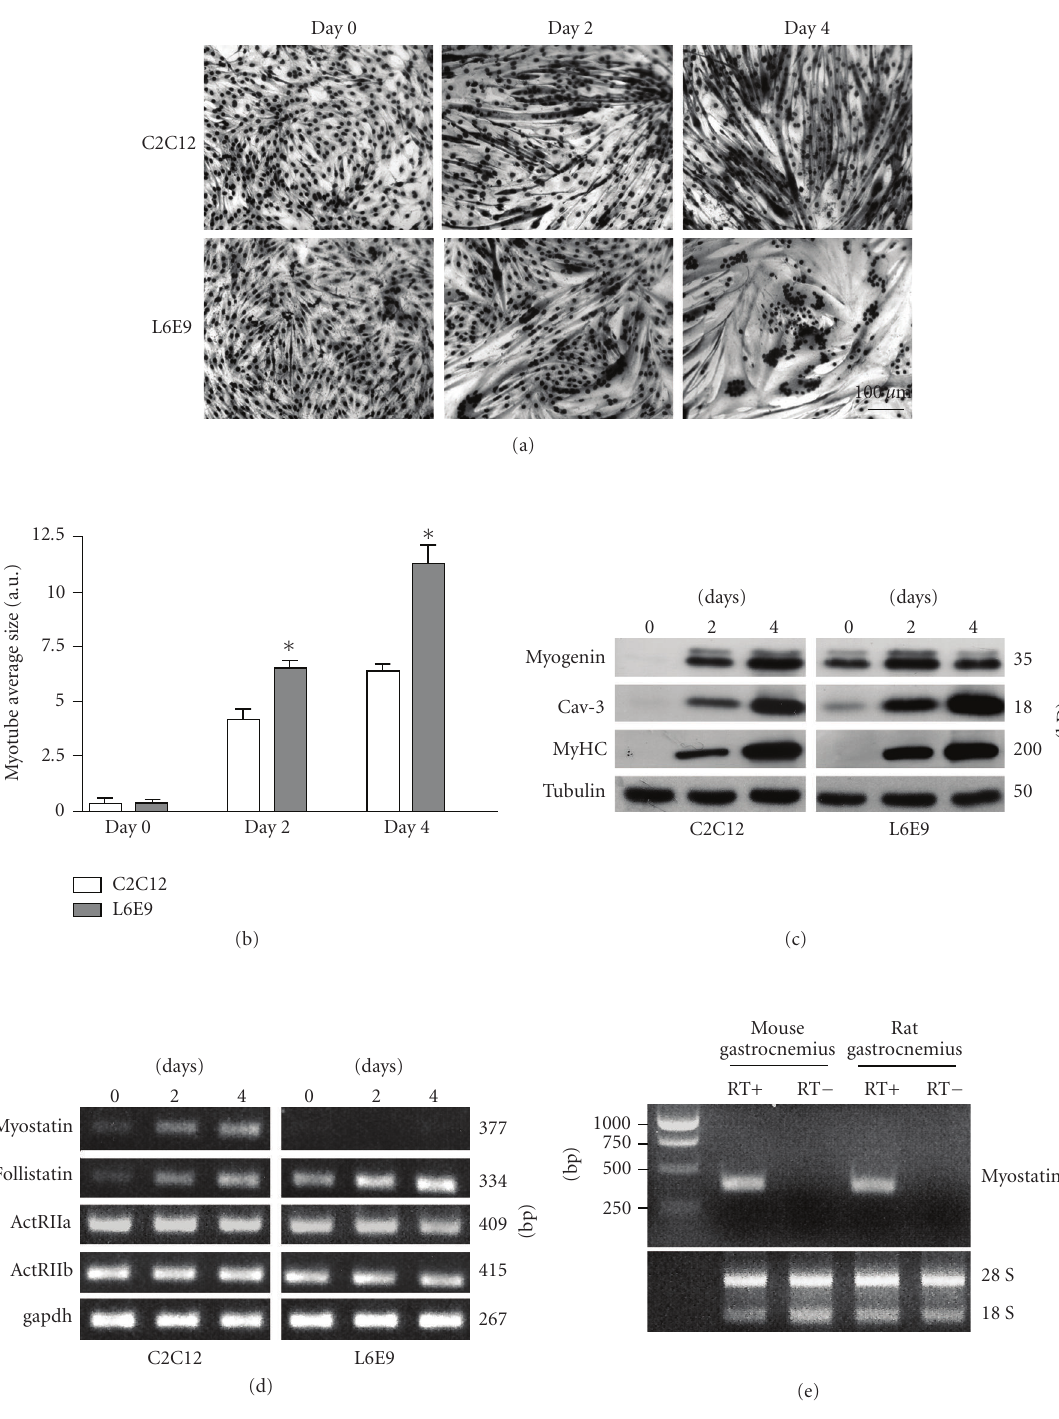
Figure 1: (a) Morphological visualization of C2C12 and L6E9 myoblasts undergoing di ff erentiation. After Giemsa staining, phase contrast pictures were taken under the same magnification. Bar = 100 μ m. (b) The graph represents the quantification of myotube average size in di ff erentiating C2C12 and L6E9 cells. ∗ P < . 05. (c) Immunoblotting was performed to compare the time-course expression of myogenin, Cav-3 and MyHC between C2C12 and L6E9 cells. Tubulin was used as loading control. (d) Semiquantitative RT-PCR analysis was performed to detect the transcript levels of myostatin, follistatin, ActRIIa, and ActRIIb in C2C12 and L6E9 cells cultured in di ff erentiating medium. Gapdh amplification was performed as loading control. (e) RT-PCR analysis was carried out to amplify a 377bp long fragment of myostatin in both mouse and rat gastrocnemius muscles. The amplification was performed by using the total RNA processed in presence or absence of reverse transcriptase (RT+ or RT − , resp.). Total RNAs are shown as loading